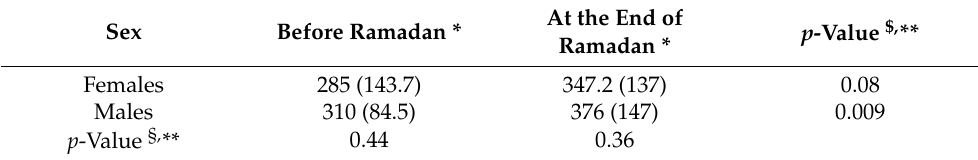
At the End of p -Value $, ** Ramadan *